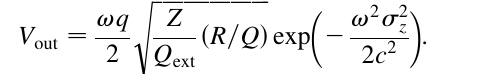
(monopole mode) 010